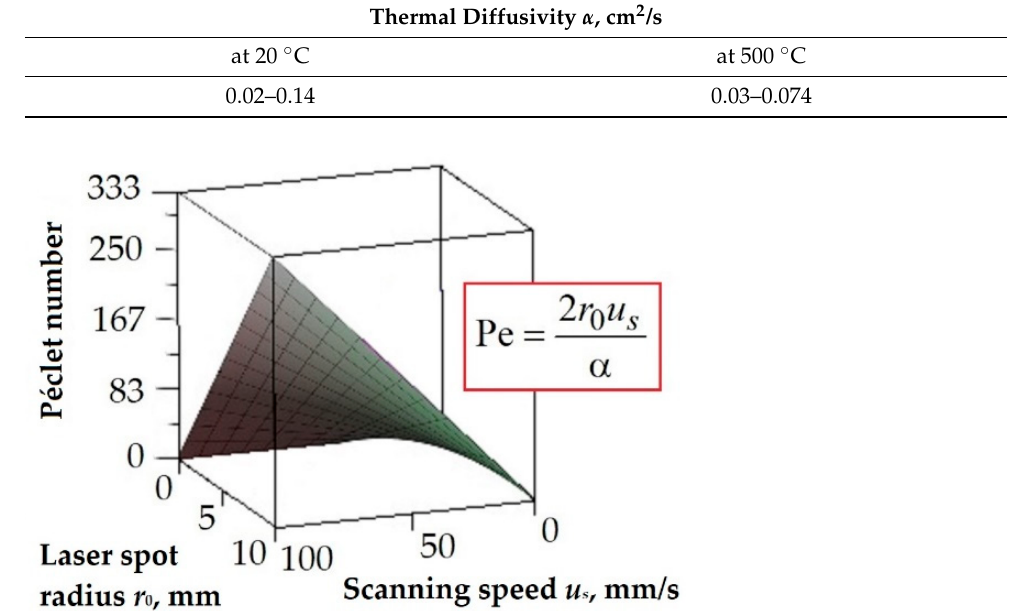
Table 5. Parameters of laser powder bed fusion chosen for modeling. Factor Measuring Unit Values Absorbed power of the beam, P W 100 400 Laser beam radius, r 0 mm ~0.1/2 ~0.3/2 Scanning velocity, u s m/s 0.0213 0.0286 Normalized power density W/m 2 0.320 × 10 8 0.142 × 10 8 distribution, q 0 Specific energy contribution, E J/m 2 1.5 × 10 5 0.5 × 10 5 P é clet’s number, Pe - 0.71 2.86 Two numerical calculations for Gaussian (Equation (1)) and donut (Equation (4)) laser beam profiles are made for each group. Thermal diffusivity of CoCr alloy is presented in Table 6 [58,59]: λ α = where ρ is density, kg/m 3 and C p is specific heat capacity, J/(kg · K). The dependence of the P é clet number on the laser spot radius and scanning speed for a cobalt-chromium alloy is shown in Figure 8. Table 6. Thermal diffusivity α of CoCr alloy.